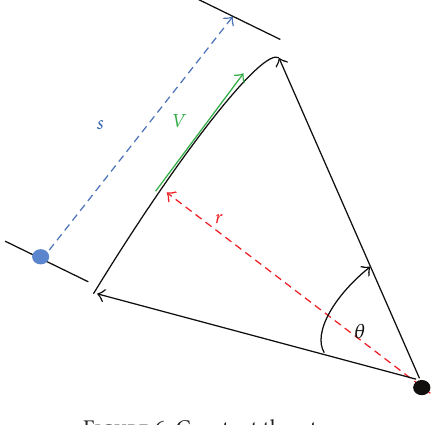
Figure 6: Constant thrust arc.